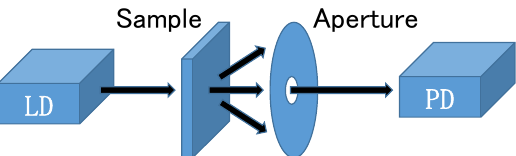
Figure 2. Measurement setup. LD: laser diode, PD: photodiode. A voltage source is not shown but is connected to the